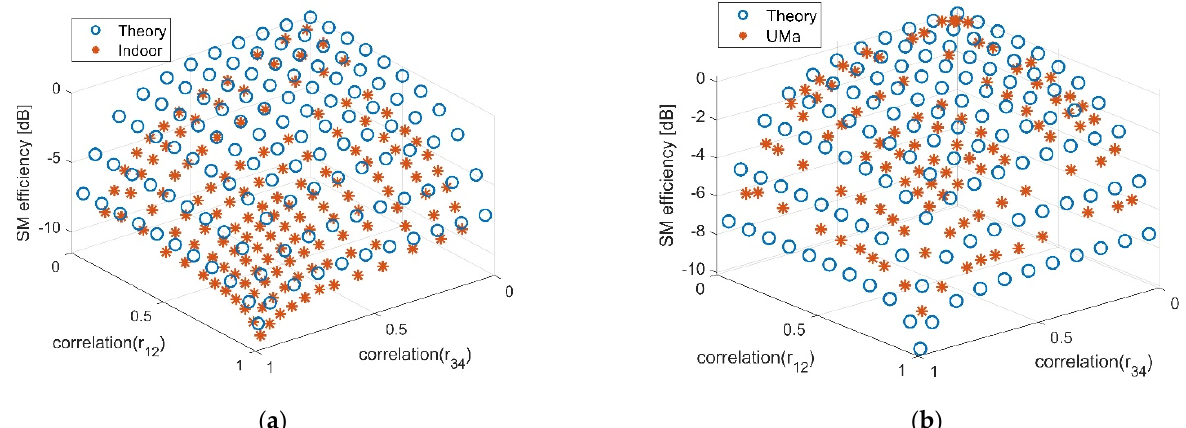
Figure 4. SM efficiency (considering only correlations) with the QuaDRiGa channel model. ( a ) Indoor scenario; ( b ) UMa scenario.